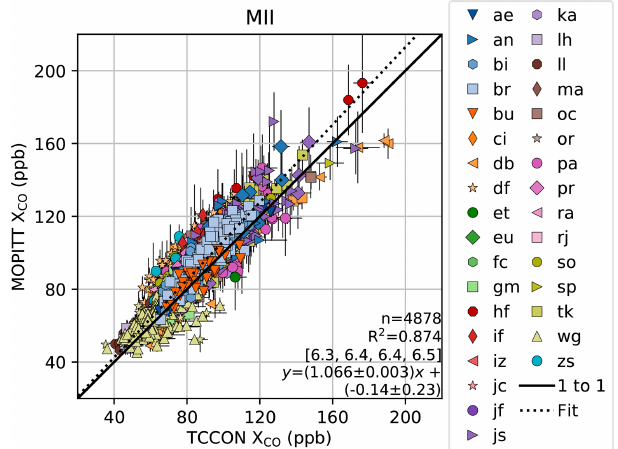
Figure 5. One-to-one plot comparing MOPITT and TCCON, fol- lowing method II (similar to Wunch et al., 2011b, Sect. S6). MO- PITT data were adjusted to the TCCON a priori profile ( ˆ c (cid:48) MOPITT averaging kernels were applied to TCCON data ( ˆ c M ← T ). Error bars represent standard deviations of the weighted averages. Triangles represent soundings over water, and other shapes are over land. Text is number of points or days n ; coefficient of determina- tion for ordinary least-squares regression R 2 ; and bias (in %) at 50, 75, 100, and 150ppb using the shown fit and equation for the shown fit using the methods of York et al.